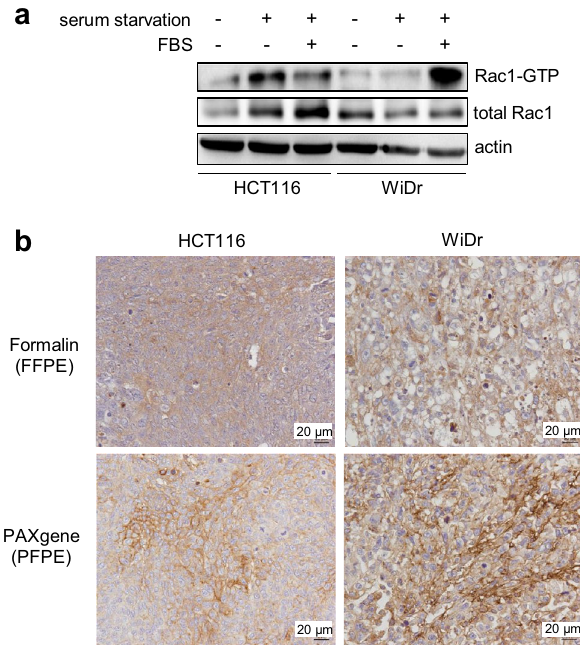
Figure 3. ( a ) Expression and activation levels of Rac and Cdc42 in the human colon cancer cell lines HCT116 and WiDr. The cells were treated as follows: Lanes 1 and 4: without serum starvation and FBS stimulation; Lanes 2 and 5: only serum starvation overnight; Lanes 3 and 6: serum starvation overnight and the subsequent FBS stimulation for 30 min, and GST pull-down assay was performed. ( b ) HCT116 and WiDr cells were subcutaneously implanted in nude mice, formed tumors were fixed in formalin (upper, FFPE) or PAXgene (lower, PFPE), and immunostaining for active Rac and Cdc42 was performed with an R-IHC